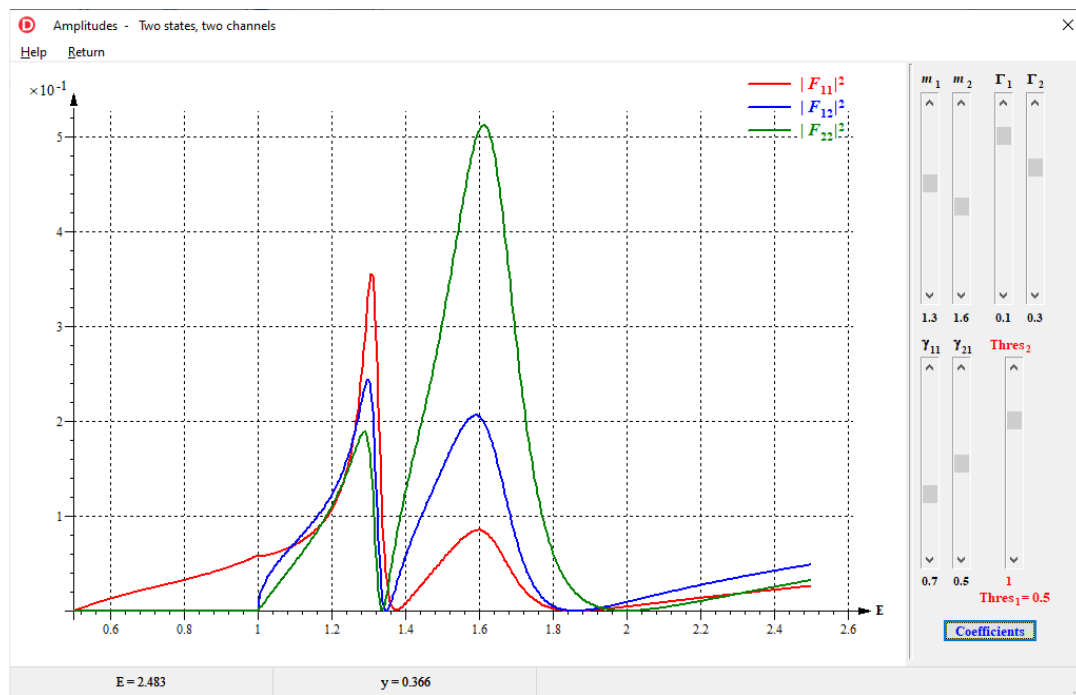
Figure A1. K-matrix scattering amplitudes. The parameters in the screenshot in Figure A1 are: m 1 = 1.3, m 2 = 1.6, Γ 1 = 0.1, Γ 2 = 0.3, γ 11 = 0.7, γ 21 = 0.5 Thres 1 = 0.5, Thres 2 = 1; here Tres i ≡ E i